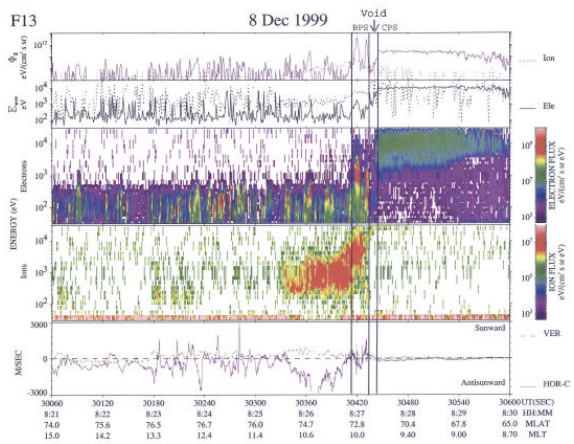
Fig. 11. Particle spectrograms and ion drift obtained from spacecraft DMSP F13 during the interval 08:21–08:30 UT on 8 December 1999. Panels 1 and 2 show differential energy flux for electrons (solid) and ions (dashed) and average energy, respectively. Panels 3 and 4 show color-coded particle spectrograms for electrons and ions, respectively. Panel 5 show ion drift in the horizontal (cross track; violet) and vertical (upward; green) directions. Different precipitation regimes are marked by vertical guidelines. The precipitation void at the equatorward boundary of the BPS regime is marked by an arrow.